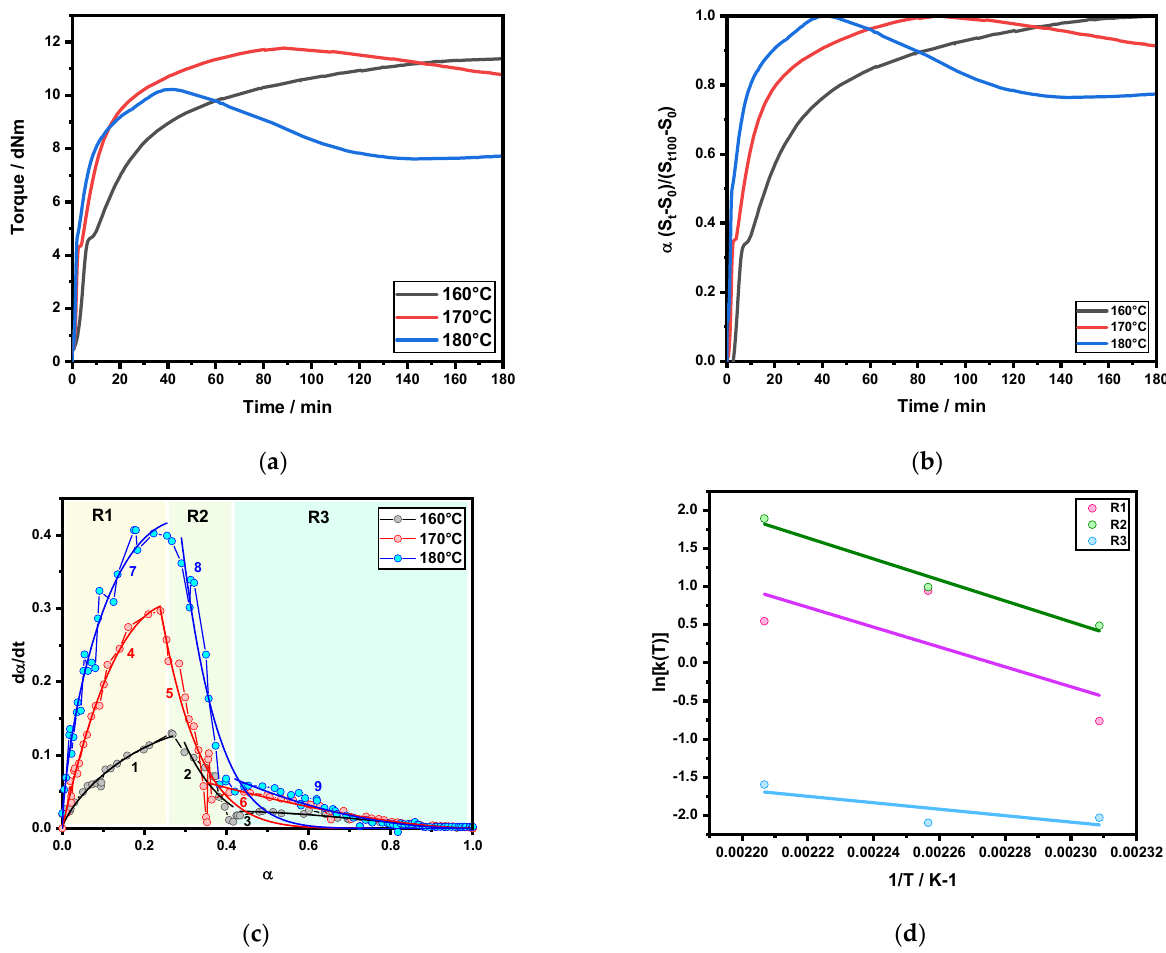
Figure 3. Kinetics and curing parameters derived from rheology of CR/TLP 2%: ( a ) Torque vs. time at temperatures of 160